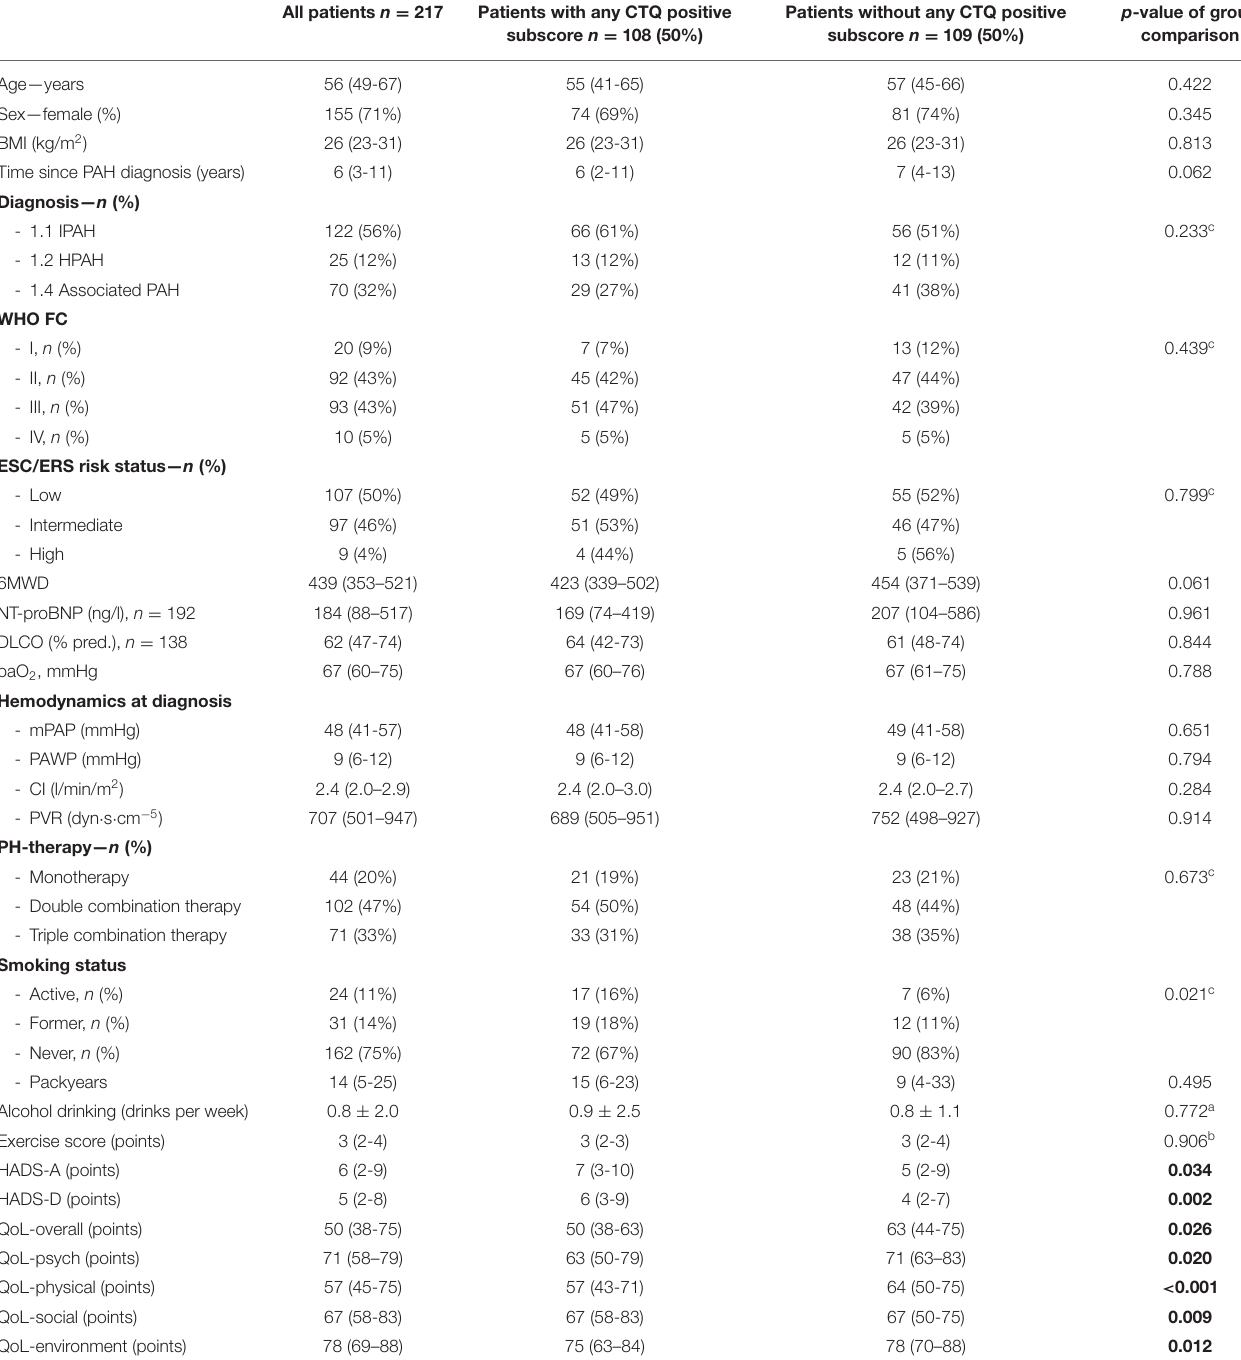
TABLE 1 | Patient characteristics.